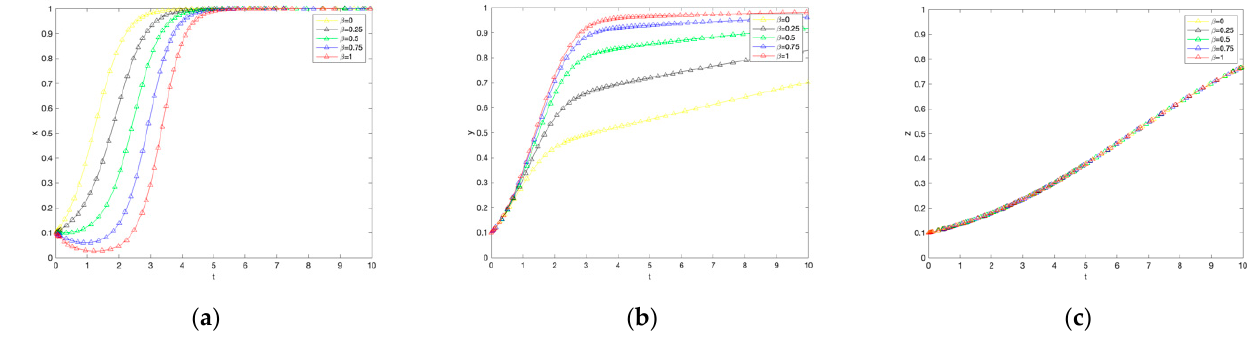
Figure 5. The impact of changes in consumer trust coefficients on government subsidies, farmer adoption, and consumer purchases. ( a ) Government response. ( b ) Farmers’ response. ( c ) Consumer reaction.